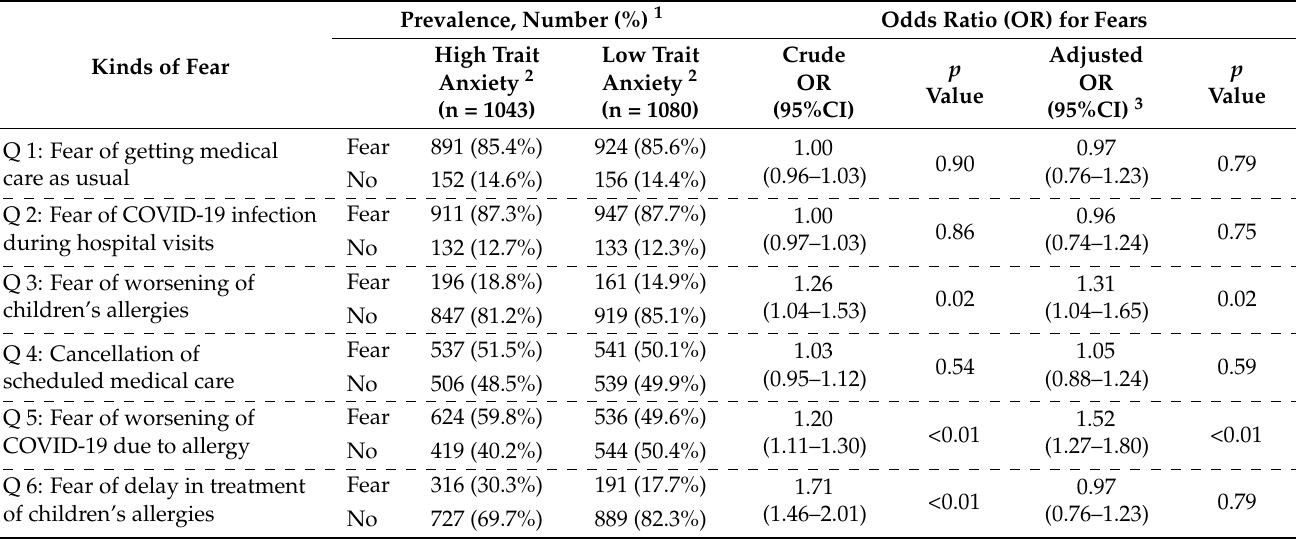
Table 3. Prevalence of fears by personality traits and odds ratio for fears.